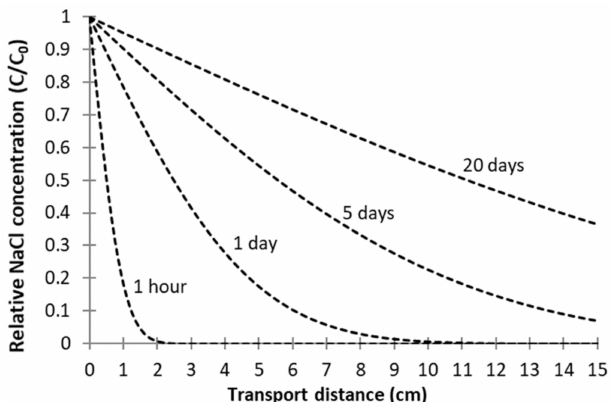
Figure 8. Theoretical breakthrough curves for the transport of NaCl by molecular diffusion in stagnant water at 20 ◦ C.